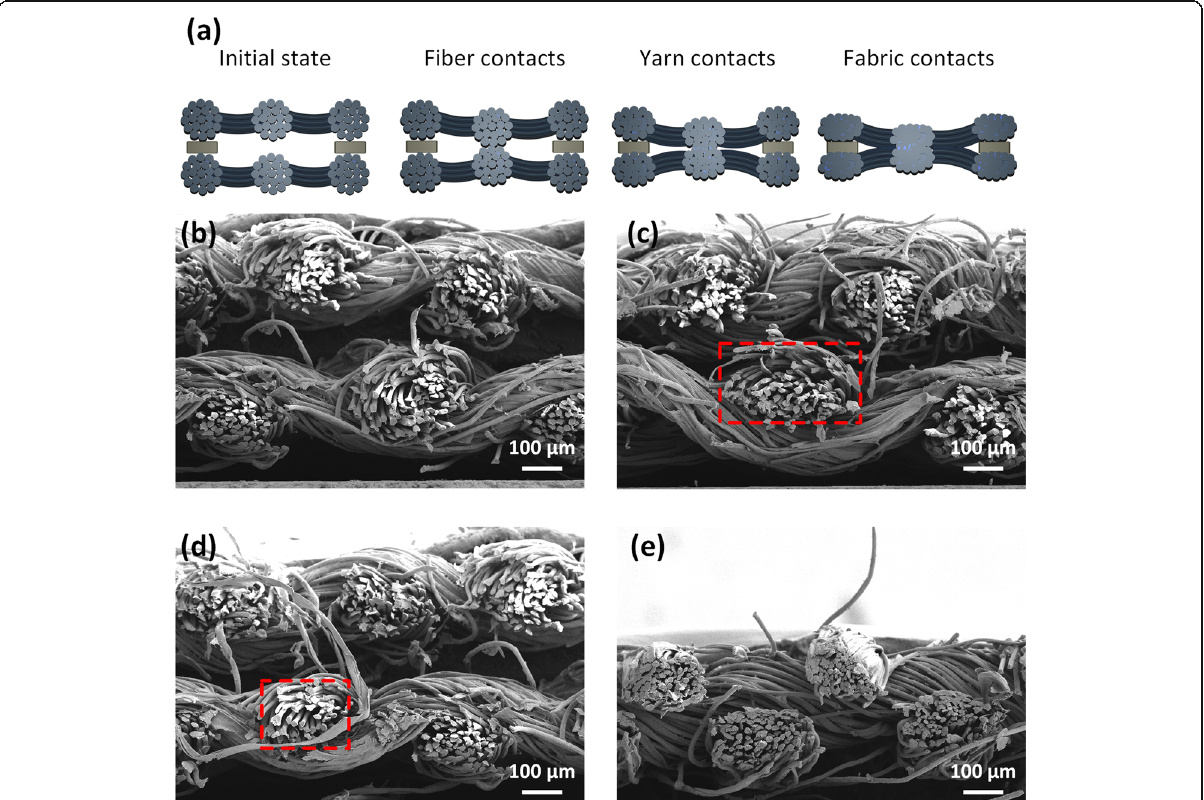
Fig. 3 The sensing principle of pressure sensor. a Schematic illustration of pressure sensing. b – e The cross-section SEM images of the AgNWs- coated fabric under different